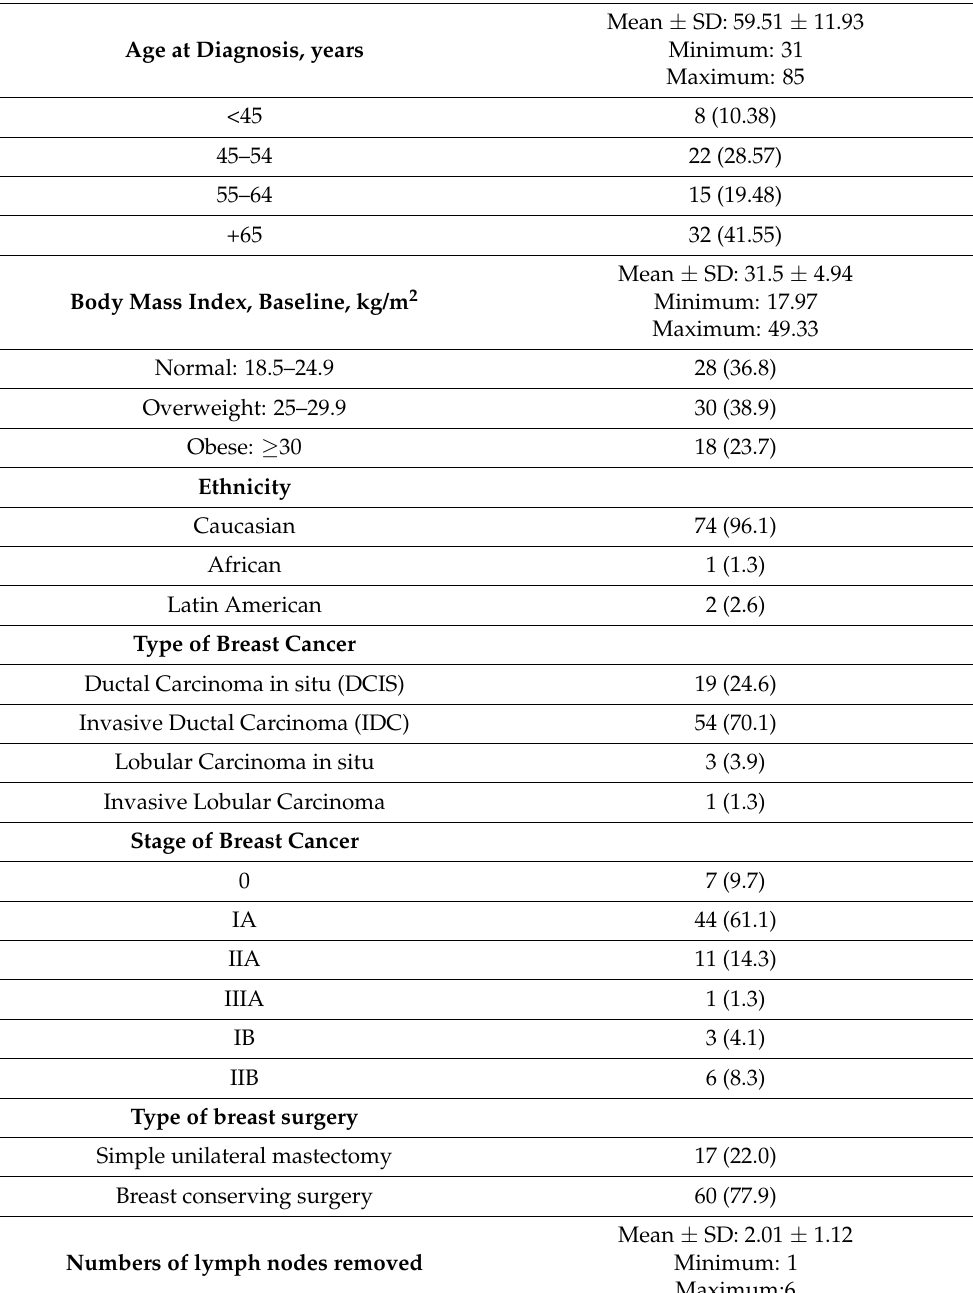
Table 1. Characteristics of the participants and evaluations of surgical scars. Demographics and